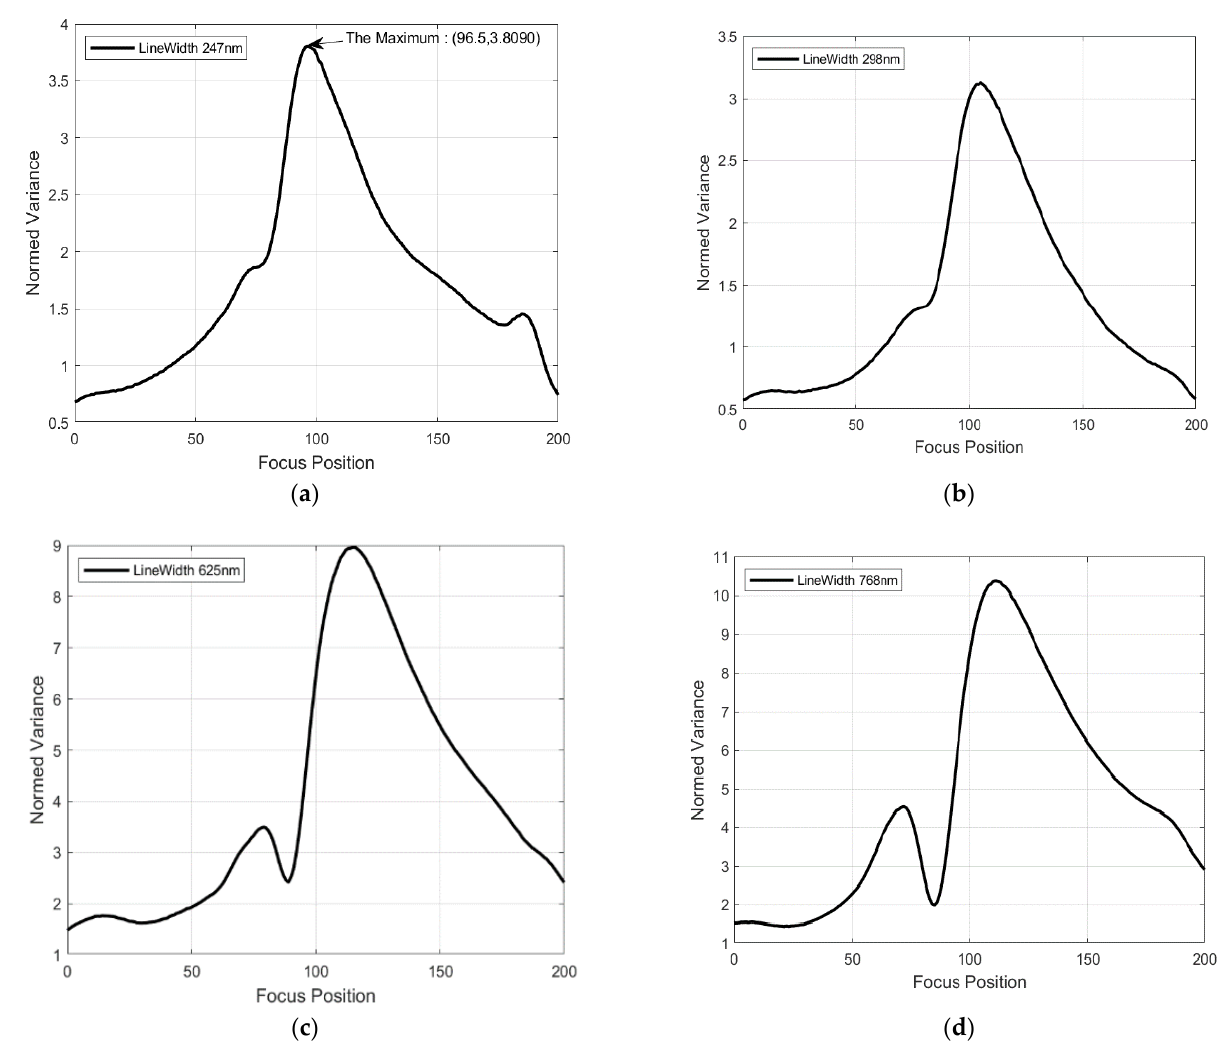
Figure 7. Focusing evaluation function curves of image series collected by lines with different linewidths. ( a ) Linewidth of 247 nm, ( b ) linewidth of 298 nm, ( c ) linewidth of 625 nm and ( d ) linewidth of 768 nm.